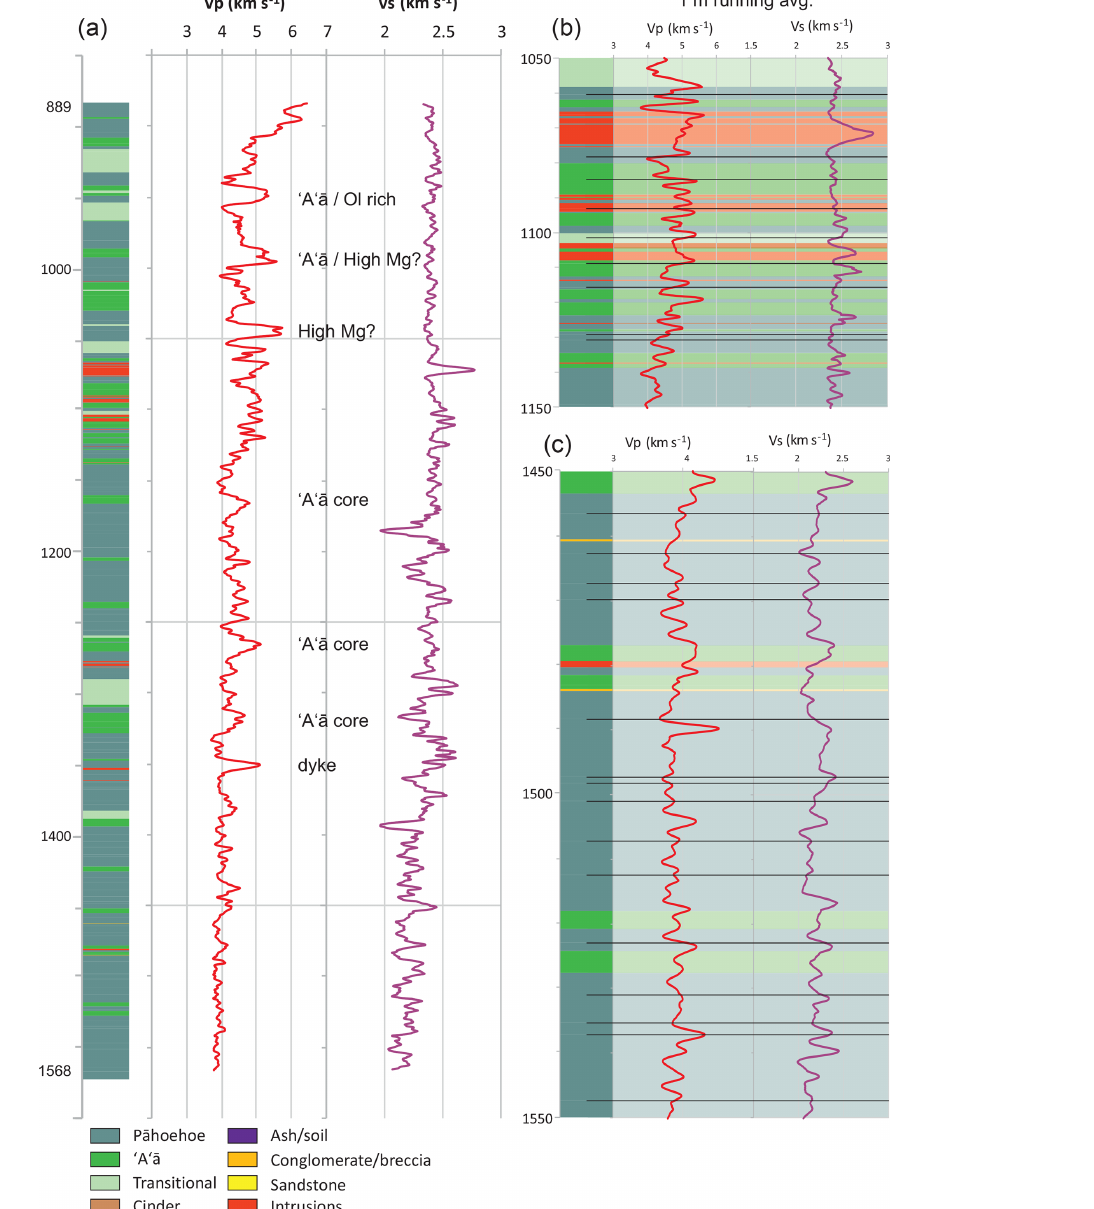
Figure 8. (a) Vp and Vs data from the PTA2 sonic log plotted against the volcanic lithofacies. (b, c) Zoomed-in logs which both display data with a 1m running average applied; black lines indicating flow and contact boundaries between similar facies. Ol rich stands for olivine